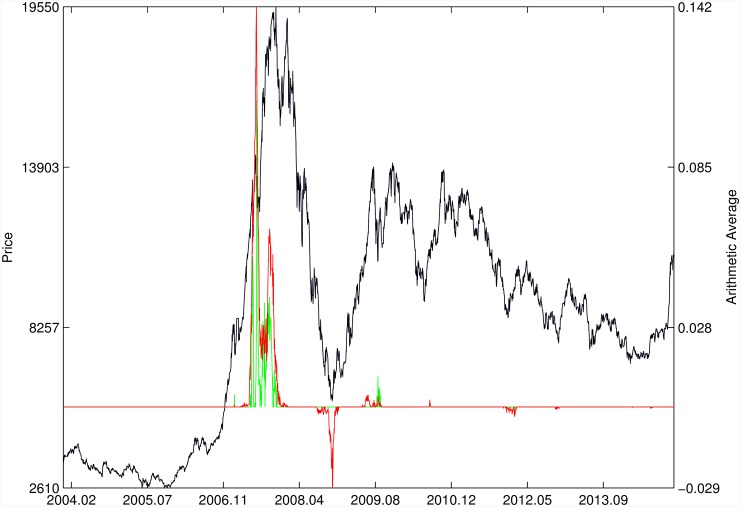
SZEC 2007/2009.Same as Fig 23.